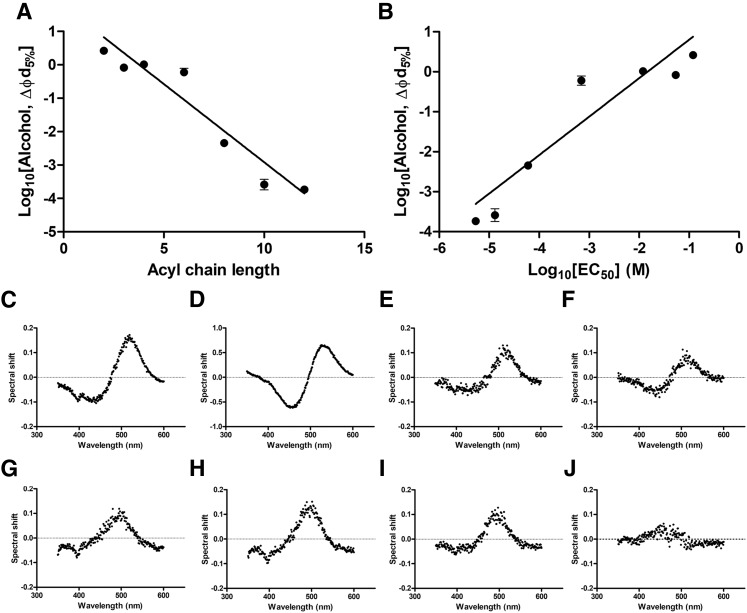
Comparing the interactions of a series of primary alcohols with artificial membrane systems and their effects on the membrane dipole potential. A: The concentration of primary alcohol required to induce a 5% (∼18 mV) reduction in the membrane dipole potential versus acyl chain length indicates a significant negative correlation (slope = −0.48 ± 0.04, Spearman’s R = −0.964, P = 0.0028) between acyl chain length and dipole potential modulating effect until tetradodecanol (C14), where a clear cut-off point is observed. B: A significant positive correlation (slope = 0.9618 ± 0.09172, Spearman’s R = 0.964, P = 0.0028) between the effect of primary alcohols on dipole potential modulation and anesthetic potency previously reported in tadpoles (51, 52). C–J: The fluorescence excitation spectra of di-8-ANEPPs-labeled liposomes shifts in response to addition of primary alcohols [ethanol (C), propanol (D), butanol (E), hexanol (8.9 mM) (F), octanol (2.7 mM) (G), decanol (0.26 mM) (H), and dodecanol (0.15 mM) (I)] indicative of a reduction in the membrane dipole potential. Fluorescence difference spectra obtained by subtracting excitation spectra (λem = 670 nm) of di-8-ANEPPs-labeled PC100% after addition of primary alcohols from baseline values, as previously described in the text. Interestingly, addition of 0.17 mM tetradodecanol to this artificial membrane system caused no such change in the membrane dipole potential (J).